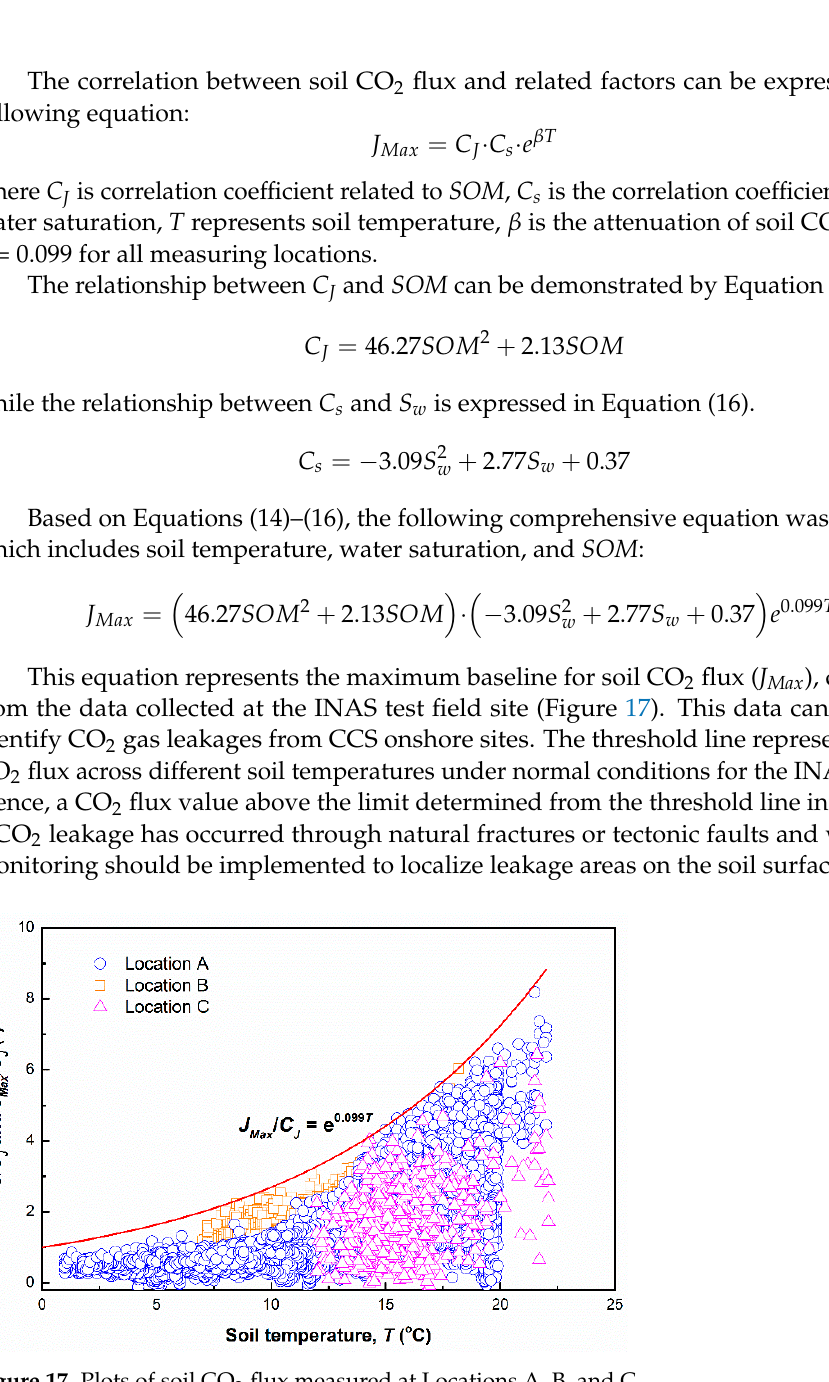
Figure 17. Plots of soil CO 2 flux measured at Locations A, B, and C.